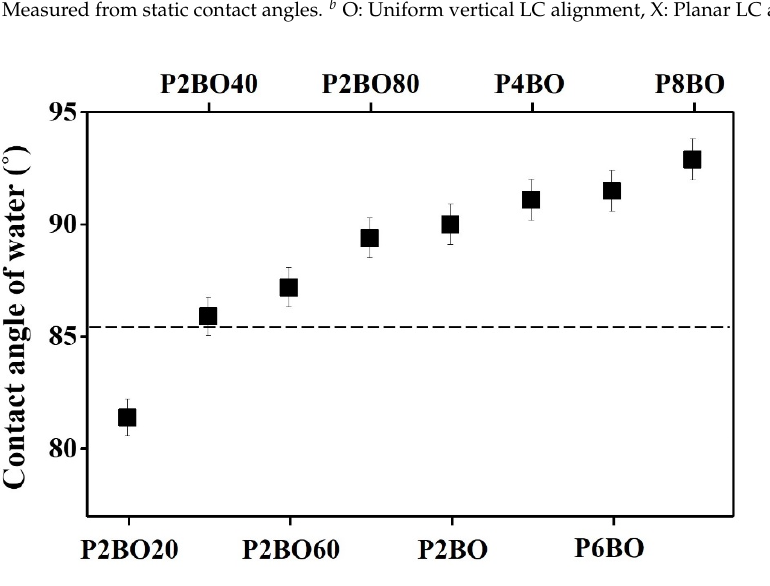
Figure 6. Water contact angle values and LC alignment behaviors of polymer films. Above and below the dashed line indicates vertical and planar LC orientation behaviors, respectively.